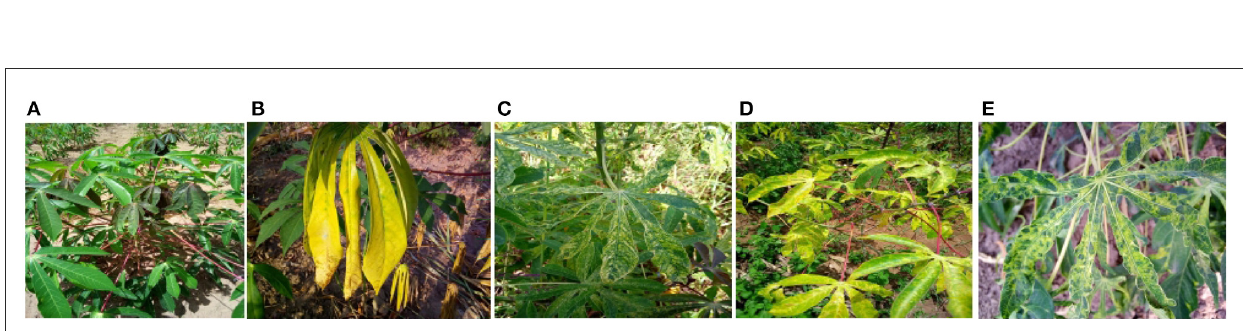
FIGURE3 Sample images associated with the cassava disease classes that trained the diagnostic component. (A) Healthy, (B) CBB, (C) CGM, (D) CBSD, and (E) CMD.